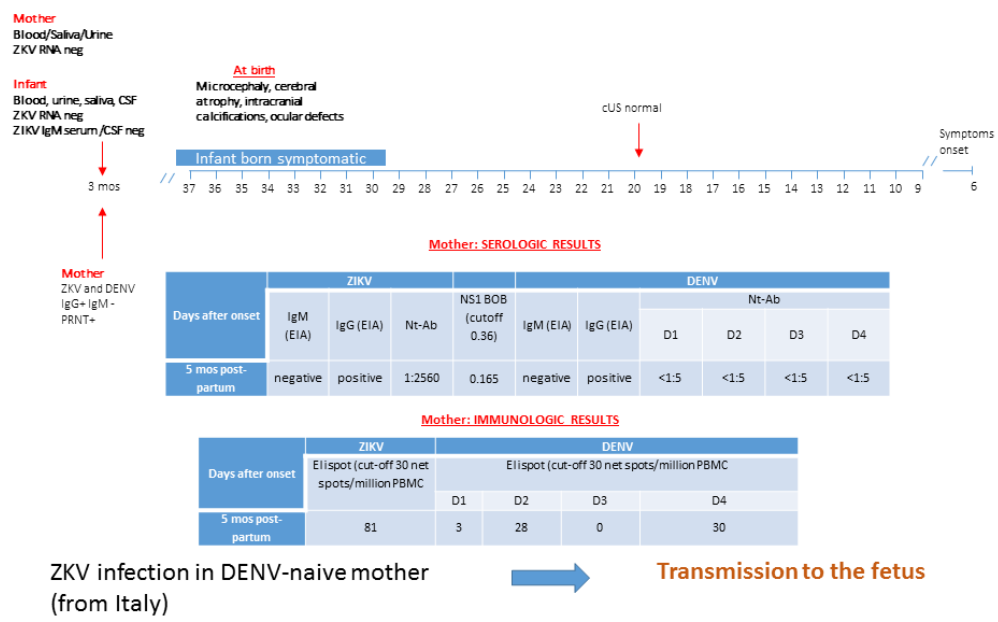
Figure 5. ZIKV infection in a DENV-naïve mother is reported. Diagnosis was performed using molecular, serological, and immunological assays, and transmission to the fetus was reported. cMRI/cUS: cerebral magnetic resonance imaging/cerebral ultrasonography; PRNT: plaque reduction neutralization test; WOP: week of pregnancy; EIA: enzyme immunoassay; IFA: immunofluorescence assay; Nt-Ab; neutralizing antibodies. In the box of molecular diagnosis, black numbers specify the week of pregnancy, while red numbers in brackets indicate the exact day of gestation. BOB assay result is expressed as the ratio of inhibition, while ELISpot assay is measured as net spots/million PBMC.